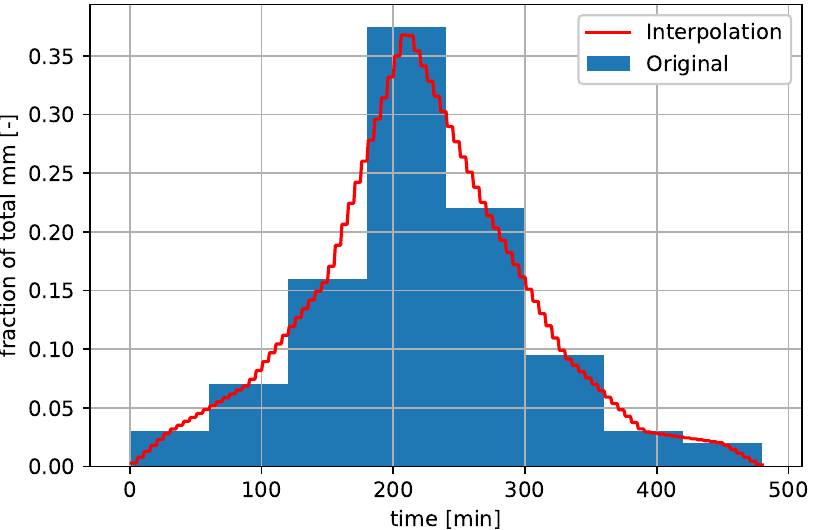
Figure 6. Example interpolation of an eight hour precipitation pattern with a peak of 37.5% of the total precipitation (precipitation pattern as given in Figure 5c).